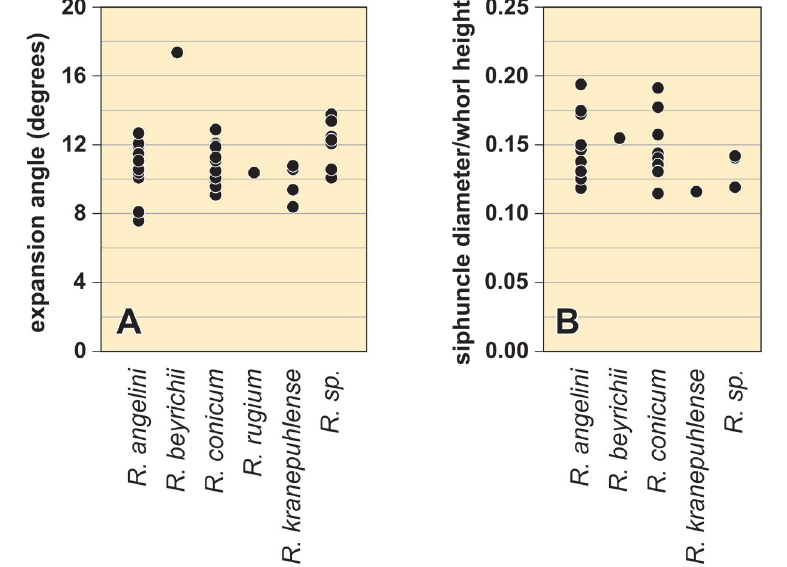
Fig. 13. Conch expansion rates (A) and siphuncle diameter rates (B) in species of Rhynchorthoceras Remelé,